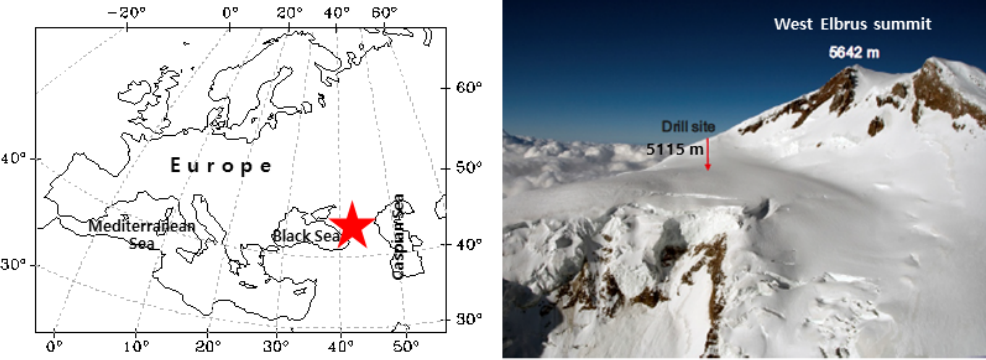
Figure 1. Location of the ice core drilling site (43 ◦ 20 (cid:48) 53, 9 (cid:48)(cid:48) N, 42 ◦ 25 (cid:48) 36, 0 (cid:48)(cid:48) E, 5115ma.s.l., indicated by the red star or arrow) at the Mt. Elbrus, western Caucasus, mountain range between the Black and Caspian